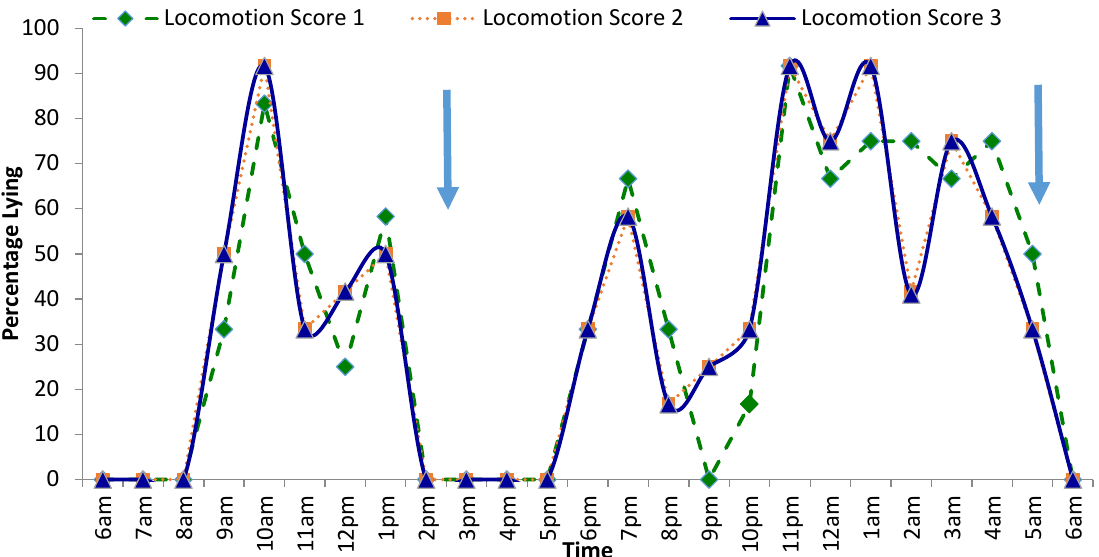
Figure 1. The activity of lactating Jersey dairy cattle over a 24 h period; solid arrows represent start of milking time (05:30 and 14:30). Bedding was refreshed between 07:00 and 08:00 and fresh feed offered around 08:00 into trough—feed was not pushed up.